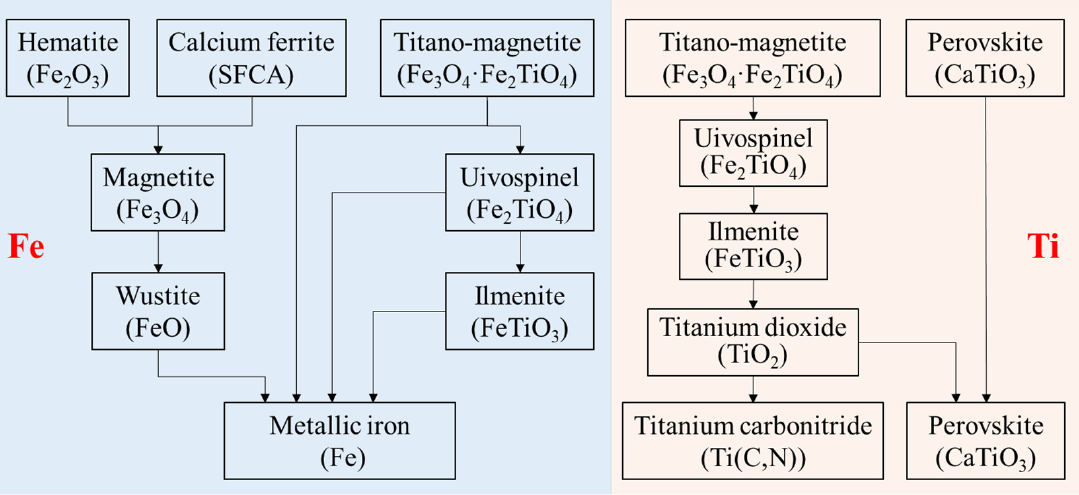
Figure 6. Migration of Ti and Fe in VTM sinter during the softening–melting